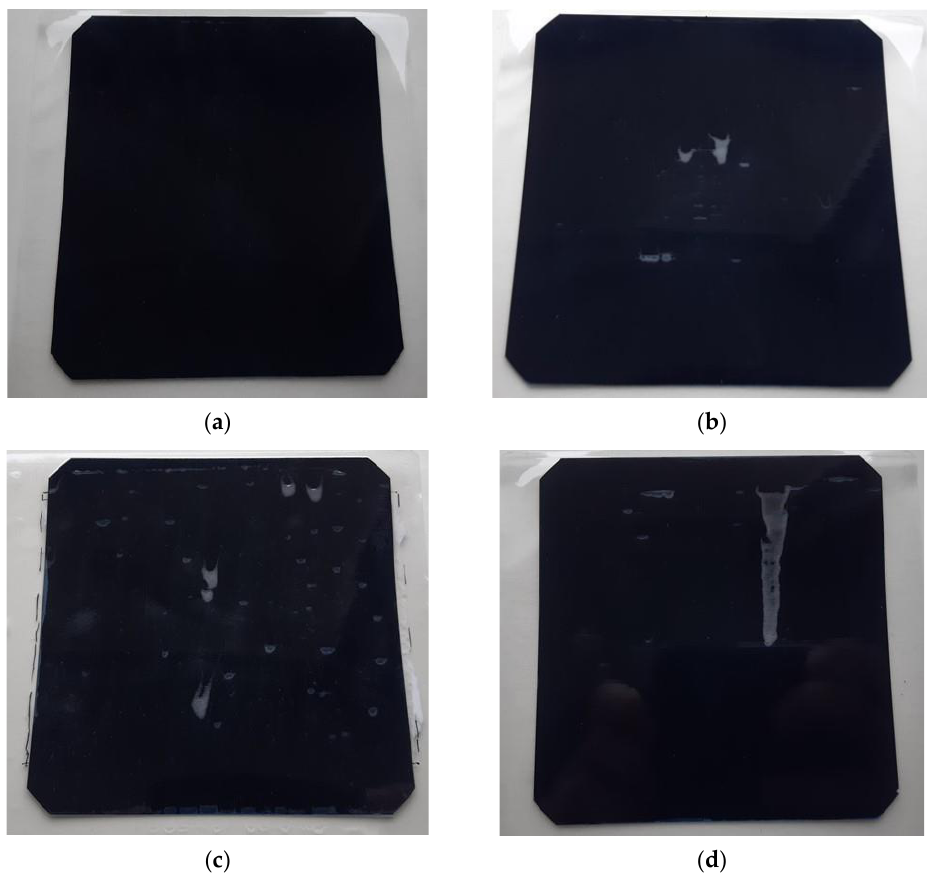
Figure 3. Laminated solar cells: ( a ) without defects; ( b ) adhesive stains on the surface caused by too fast feed; ( c , d ) damp patches from the adhesive caused by too low temperature of lamination. The selection of the appropriate lamination process parameters made it possible to